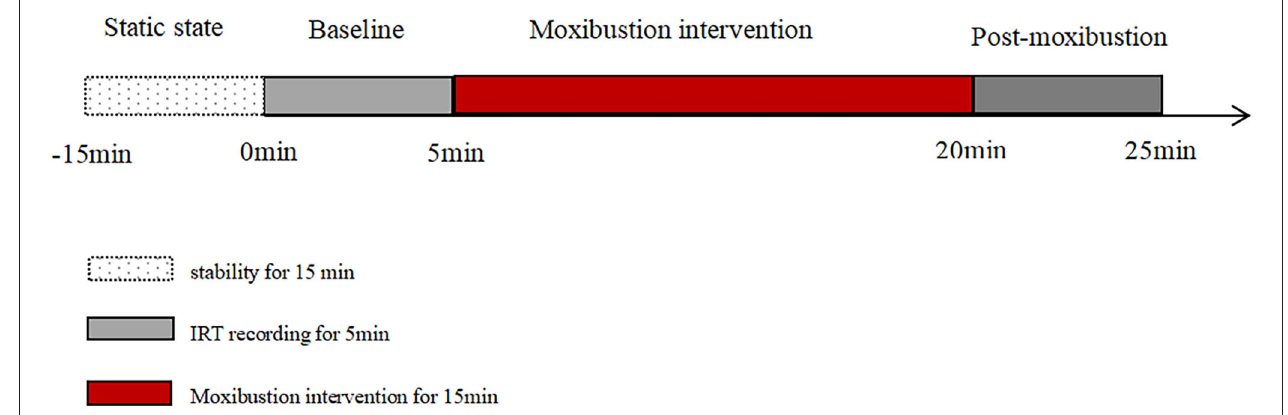
FIGURE 3 | Procedures for the IRT examination.